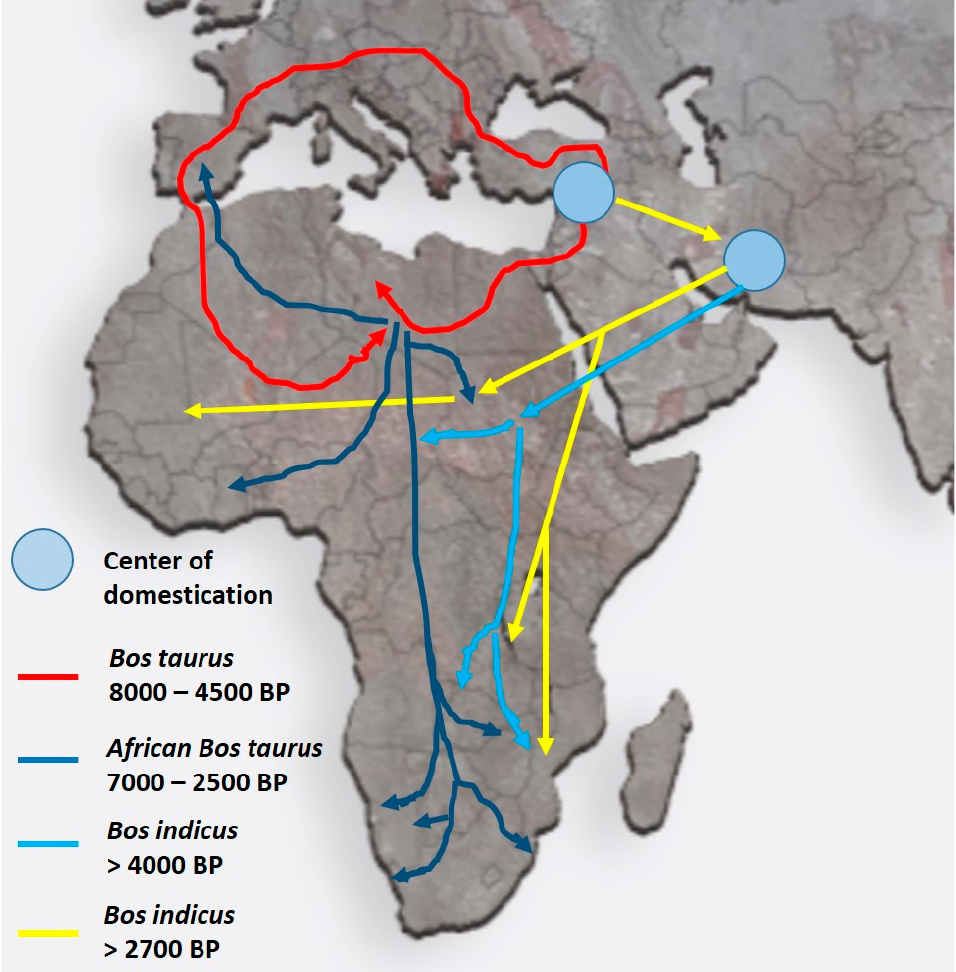
Figure 3. Migratory routes of domestic cattle from their origin in the Fertile Crescent into the northern and southern parts of Africa. Despite having different centers of domestication, both Bos taurus and Bos indicus breeds migrated into Africa. Colored arrows indicate the different routes and times of migration (after Ref. [12]). The routes and times for the migration of other domestic animals such as goats and pigs are very similar.